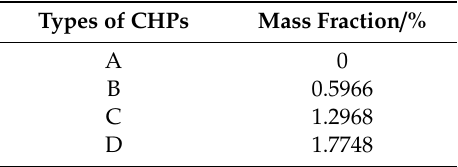
Table 5. The mass fraction of unreacted Na 2 CO